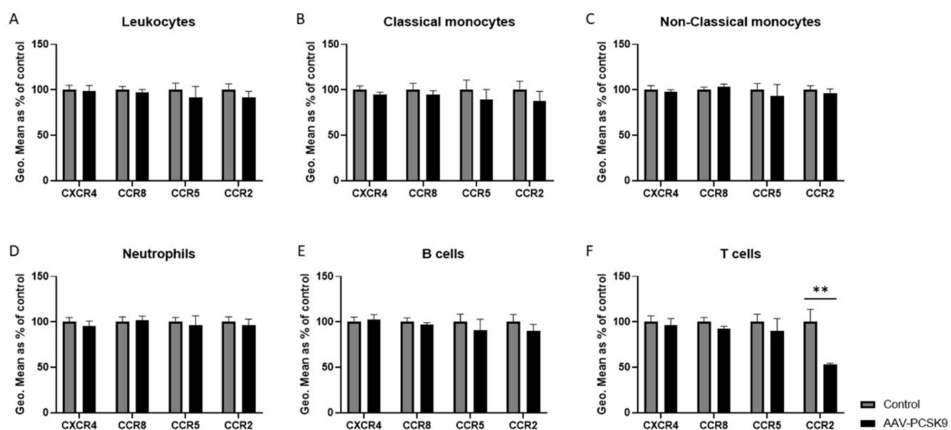
Figure 2. The expression of chemokine receptors on splenic leukocytes is not affected by PCSK9 overexpression in vivo, except in T-cells. The expression of chemokine receptors was measured using flow cytometry and represented using geometric mean (Geo.Mean) in splenic leukocytes ( A ), classical monocytes ( B ), non-classical monocytes ( C ), neutrophils ( D ), B cells ( E ), and T cells ( F ) of PCSK9 over-expressing mice ( n = 8) and compared to control mice ( n = 8). Bar graphs are a representation of mean ± SEM. ** p < 0.01. The statistical difference between the groups was calculated using 2-way ANOVA tests in GraphPad